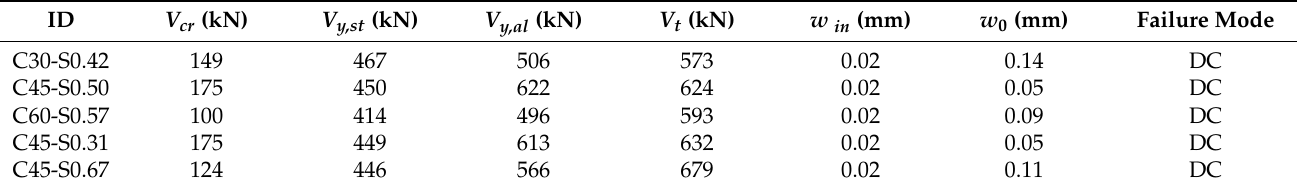
Table 4. Test results of corbel